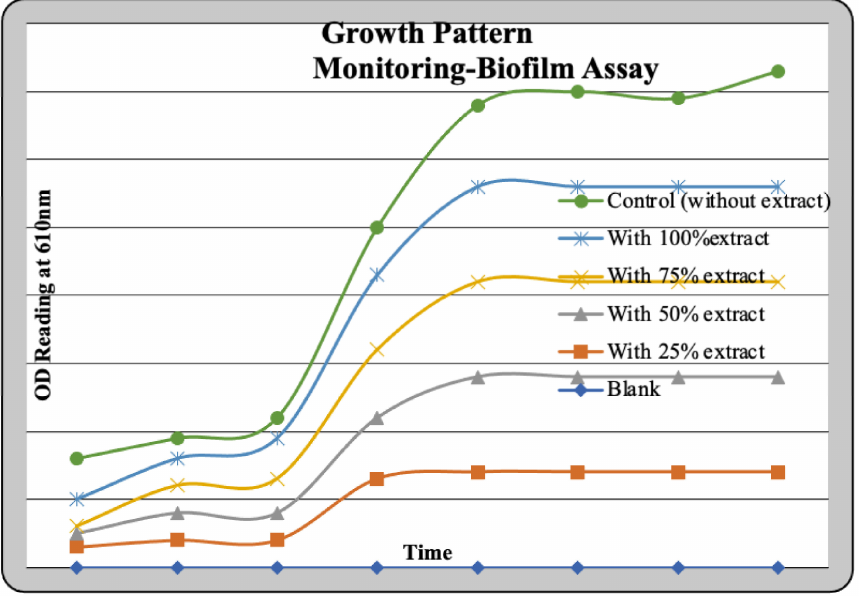
Figure 10. Growth pattern monitoring-biofilm